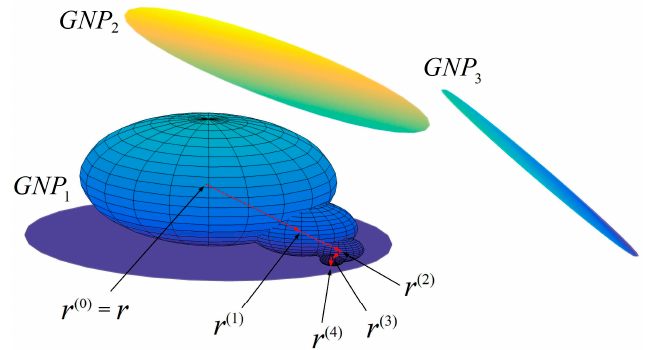
Figure 4. A random walk process on a sphere.